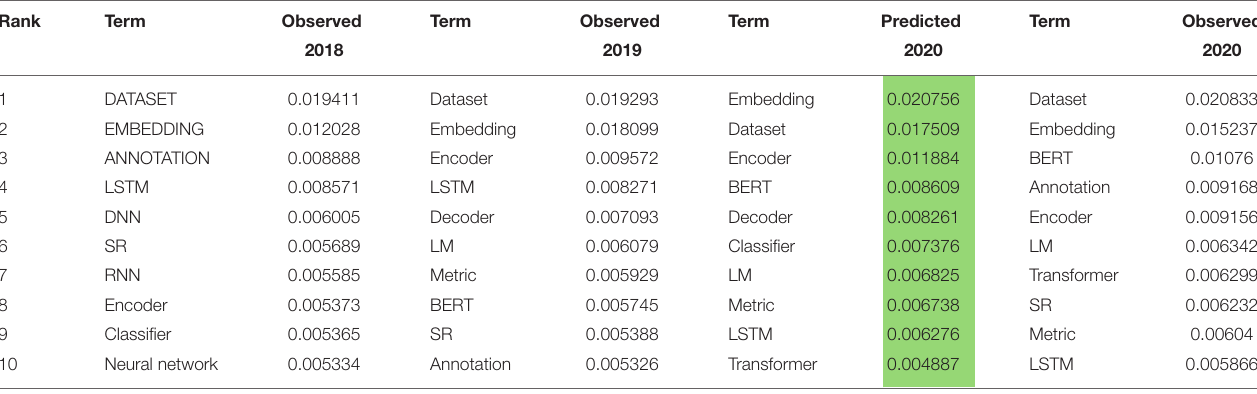
Predictions are marked in green.